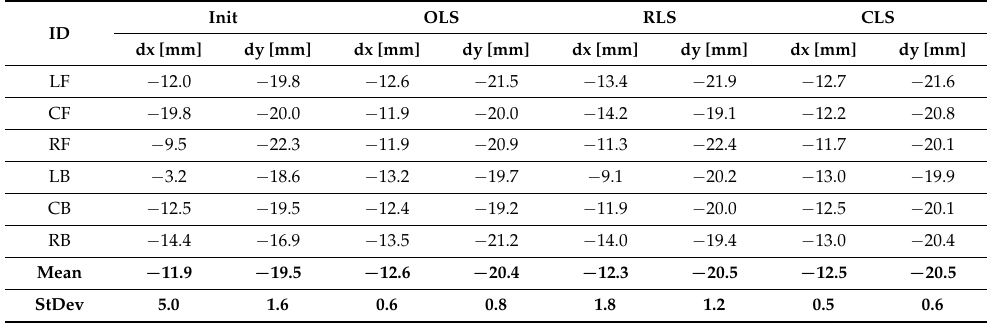
Table 2. Differences in the initial and LS-adjusted receiver coordinates in relation to the